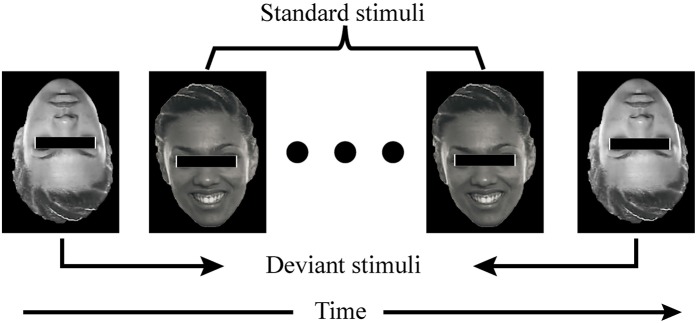
The figure demonstrates what participants saw in one item. There were several standard stimuli (at least six) between two deviant stimuli.